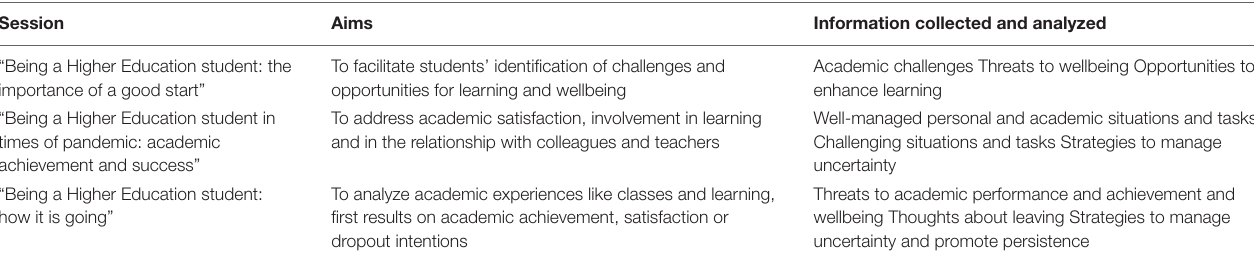
TABLE 1 | Sessions, aims, and information collected.